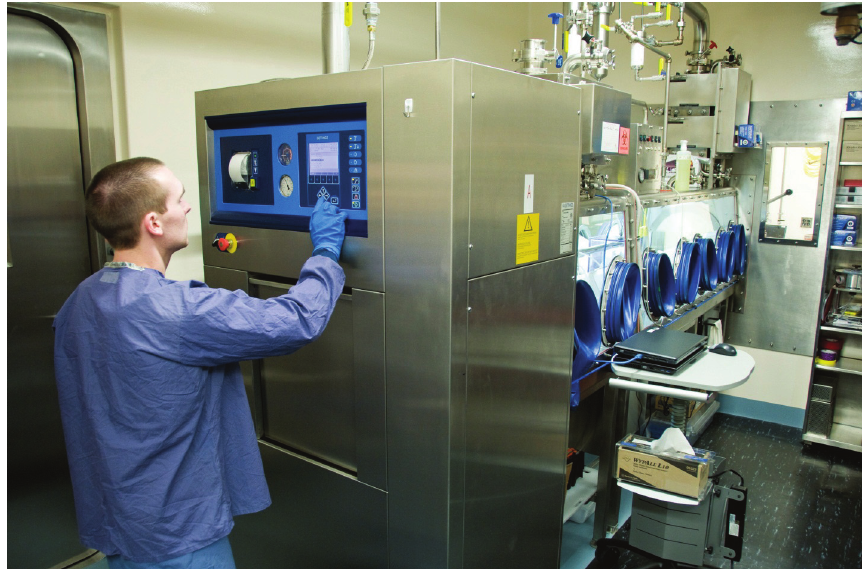
Figure 6. Interlocking double-door autoclave attached to the Class III BSC. Used contents and waste generated during an experiment inside the BSC must be sterilized after use. A researcher is selecting a pre-programmed autoclave cycle to ensure the contents within the autoclave chamber are noninfectious when the outer door is eventually opened. The door located nearest to the researcher cannot be opened until a full sterilization cycle has been completed. Biological indicators inside the autoclave chamber will be analyzed to determine agent inactivation after the sterilization